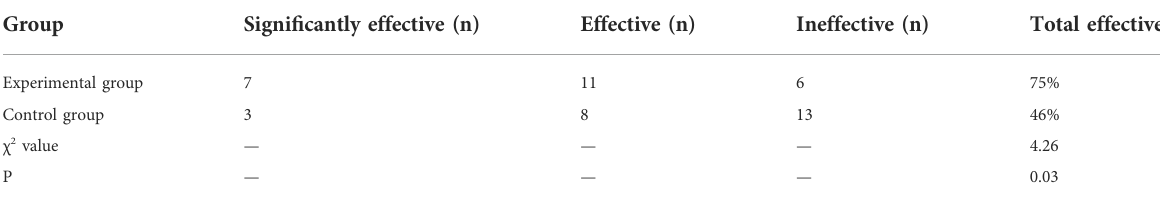
TABLE 3 Clinically effective rate of two groups.